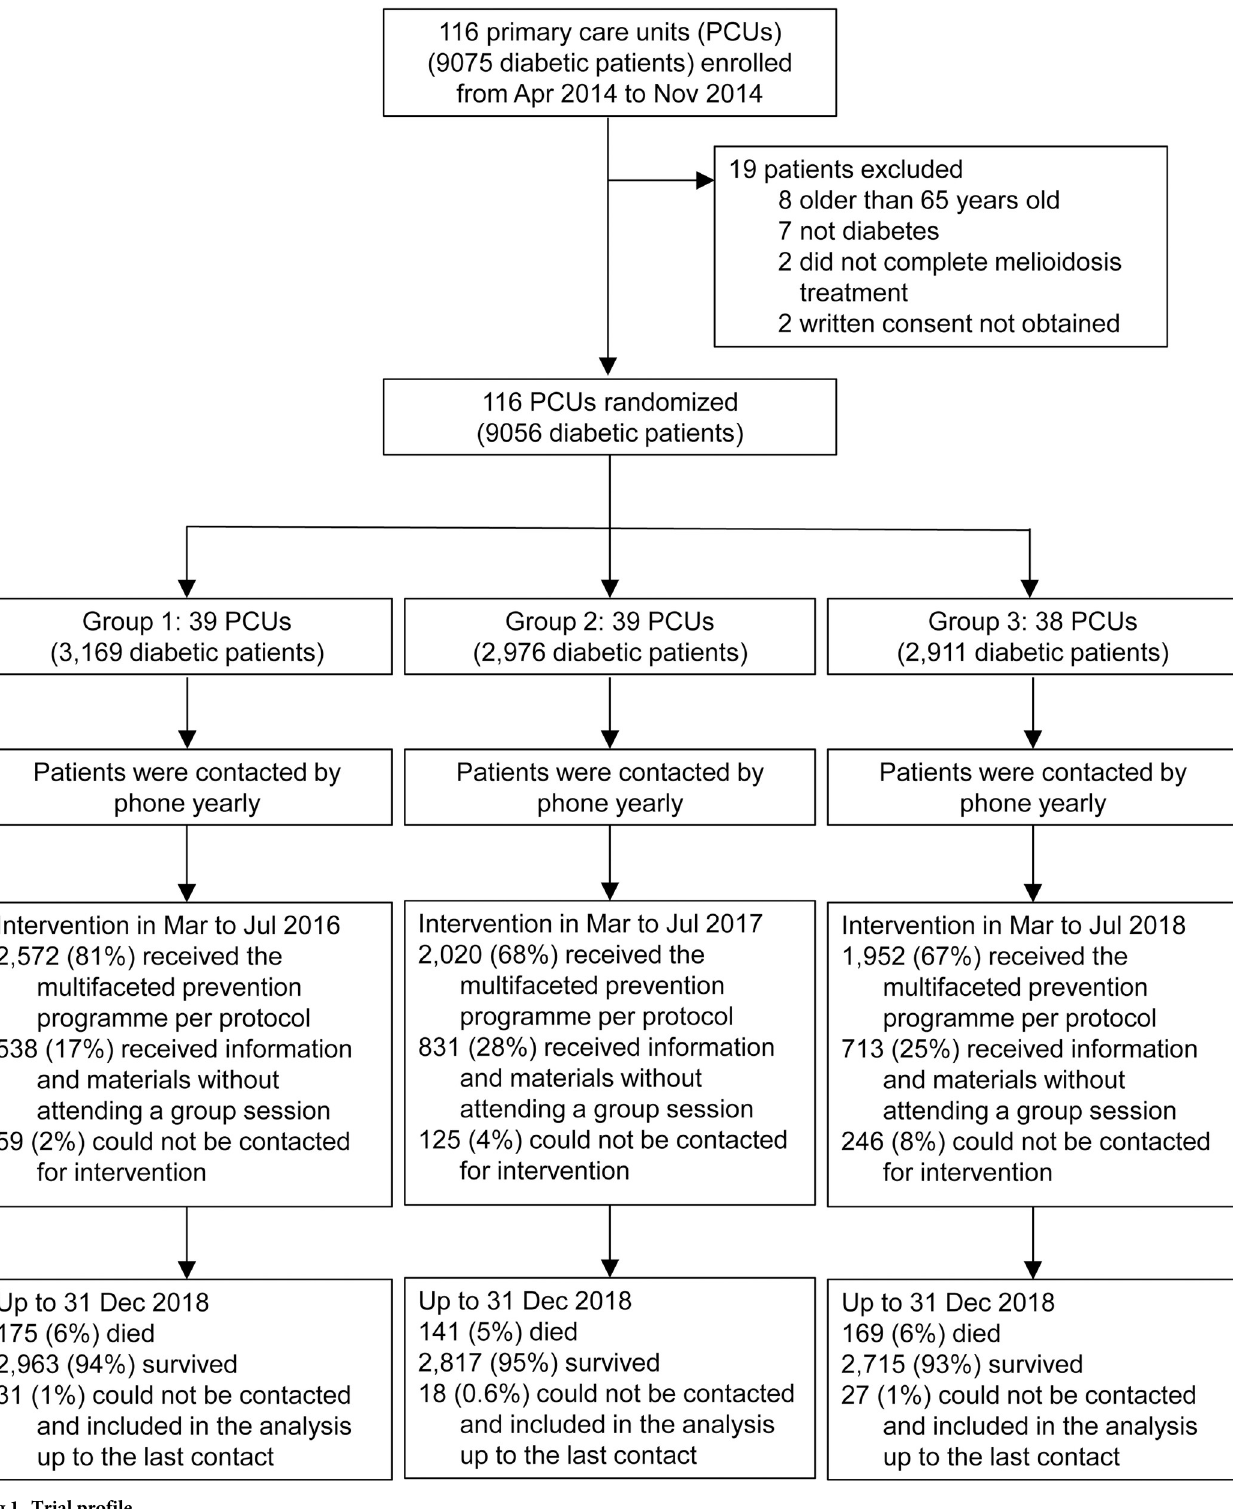
Fig 1. Trial profile.